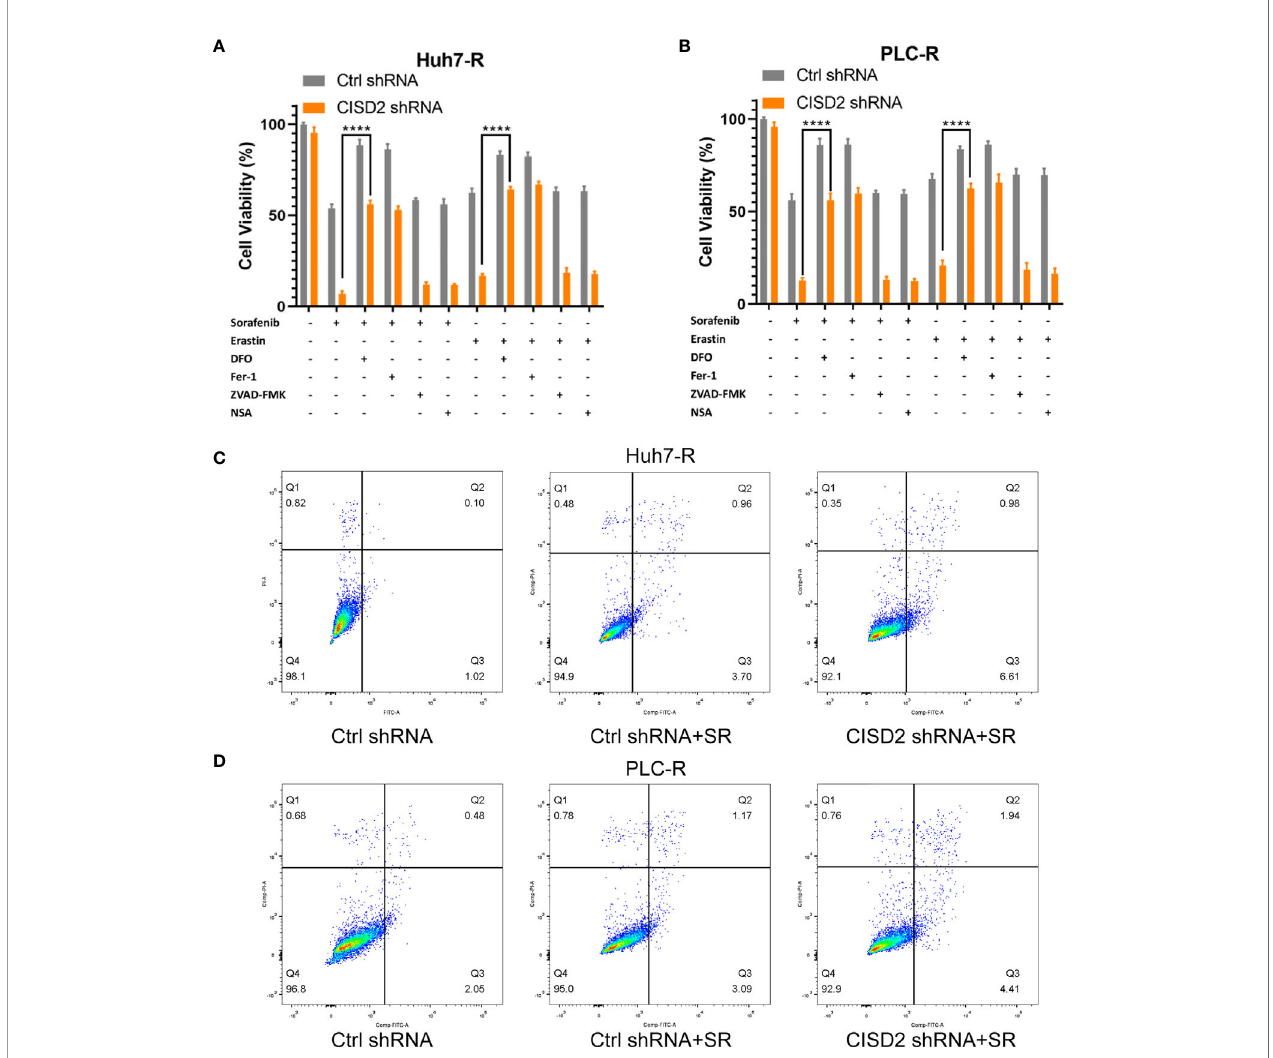
FIGURE 3 | Knockdown of CISD2 mainly promotes ferroptosis and not apoptosis in sorafenib-resistant cells. (A, B) CCK-8 method was used to detect the cell viability under different treatment with sorafenib (10 m mol) or transfected CISD2 shRNA, and erastin (10 m mol) as positive control, with or without cell death inhibitors (Fer-1, 1 m mol; DFO, 200 m mol; ZVAD-FMK, 10 m mol) (n = 3, **** P < 0.0001 versus sorafenib/erastin group). (C, D) Cell apoptosis was detected by fl ow cytometry under treatment with sorafenib (10 m mol) or transfected CISD2 shRNA (horizontal axis label FITC Annexin V and vertical axis label